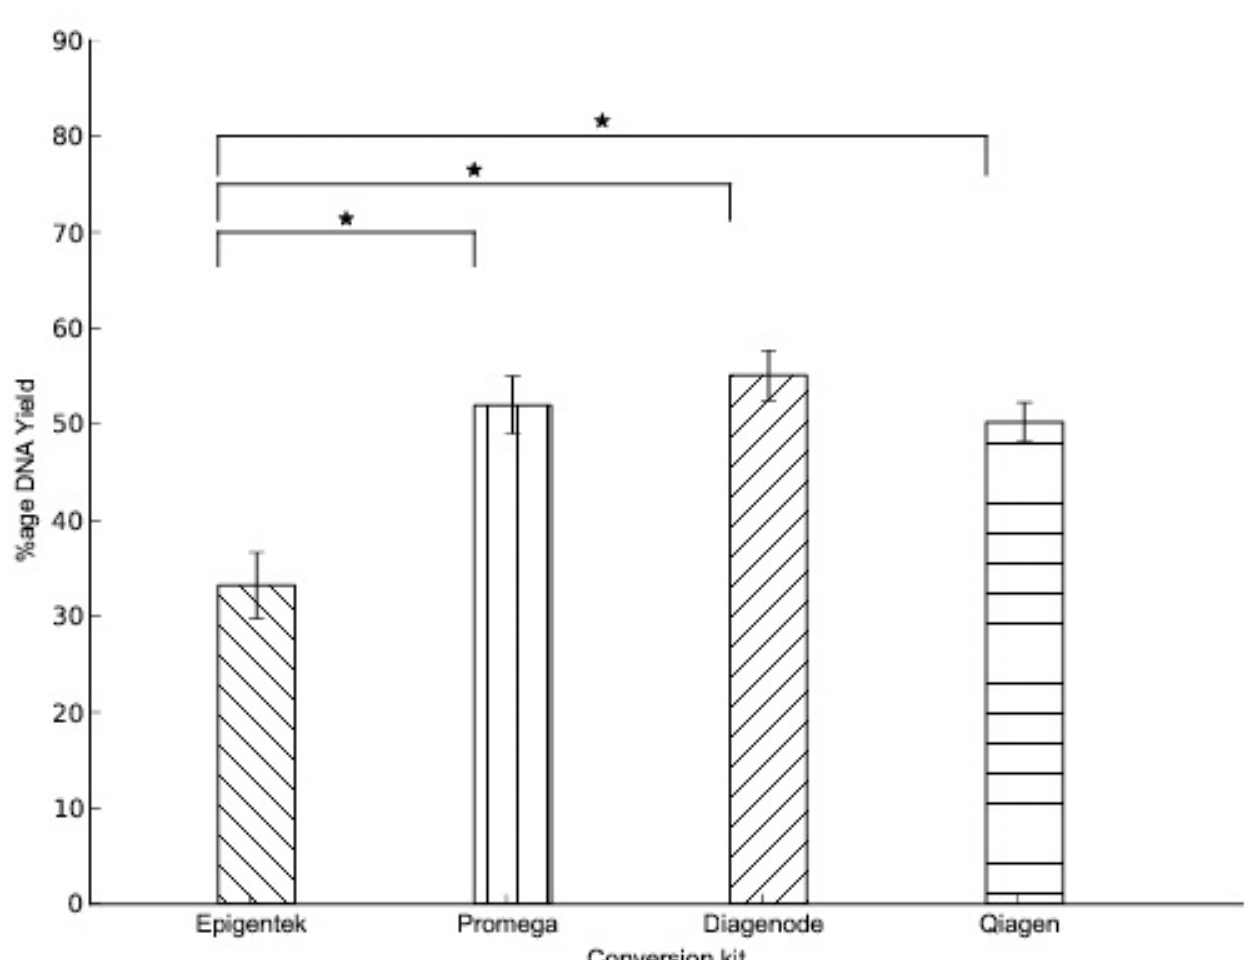
Fig 4. DNA degradation. DNA recovery after bisulfite treatment was determined with the Qubit fluorometer. DNA recovery with the Epigentek kit was 33.2% ± 3.4%, with the Promega kit was 52% ± 3%, with the Diagenode kit was 55% ± 2.6% and with the Qiagen kit was 50.2% ± 2%. The BisulFlash DNA Modification kit was shown to have a significantly decreased average yield with respect to all other kits (FWER < 0.05, f-value = 10.5, p -val = 2 . 8E-5) . Shown are the mean values of n = 12. Error bars = SD.